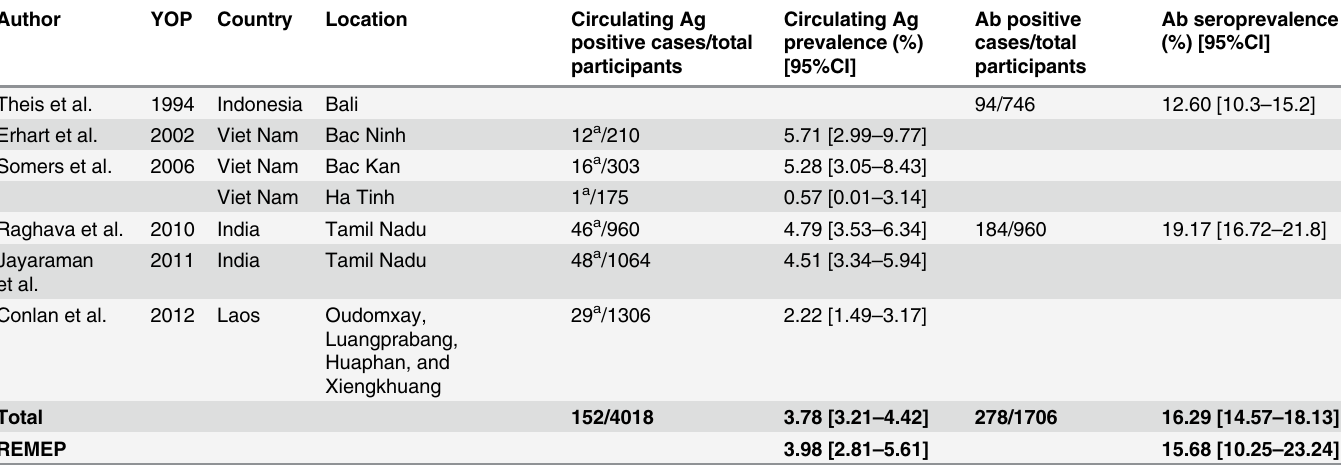
Table 3. Sero-epidemiological studies using Ag-ELISA and/or EITB for human cysticercosis in